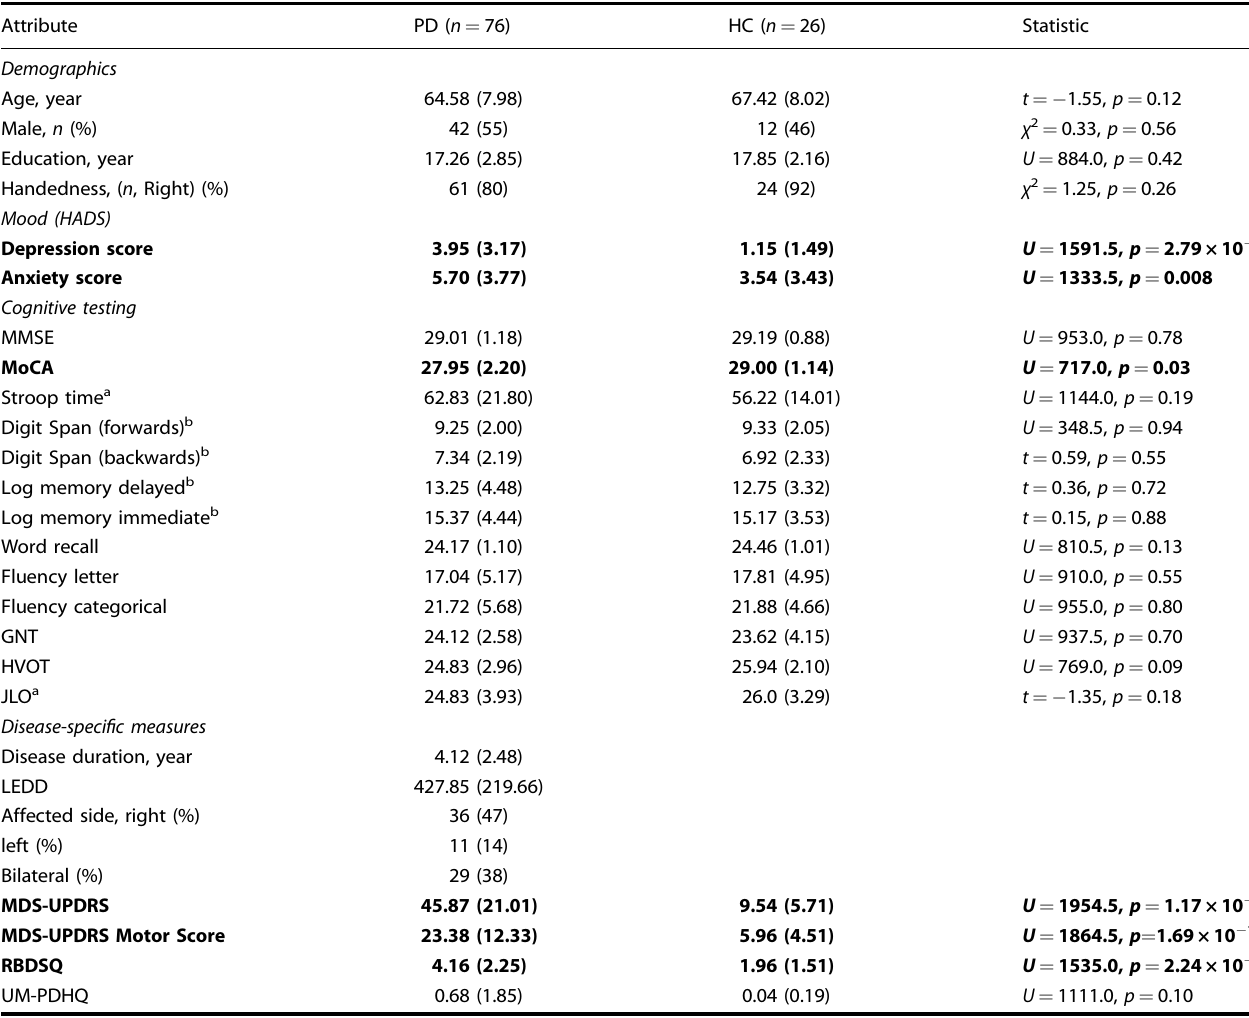
Table 1. Demographics, cognitive and disease speci fi c measures of participants with PD and